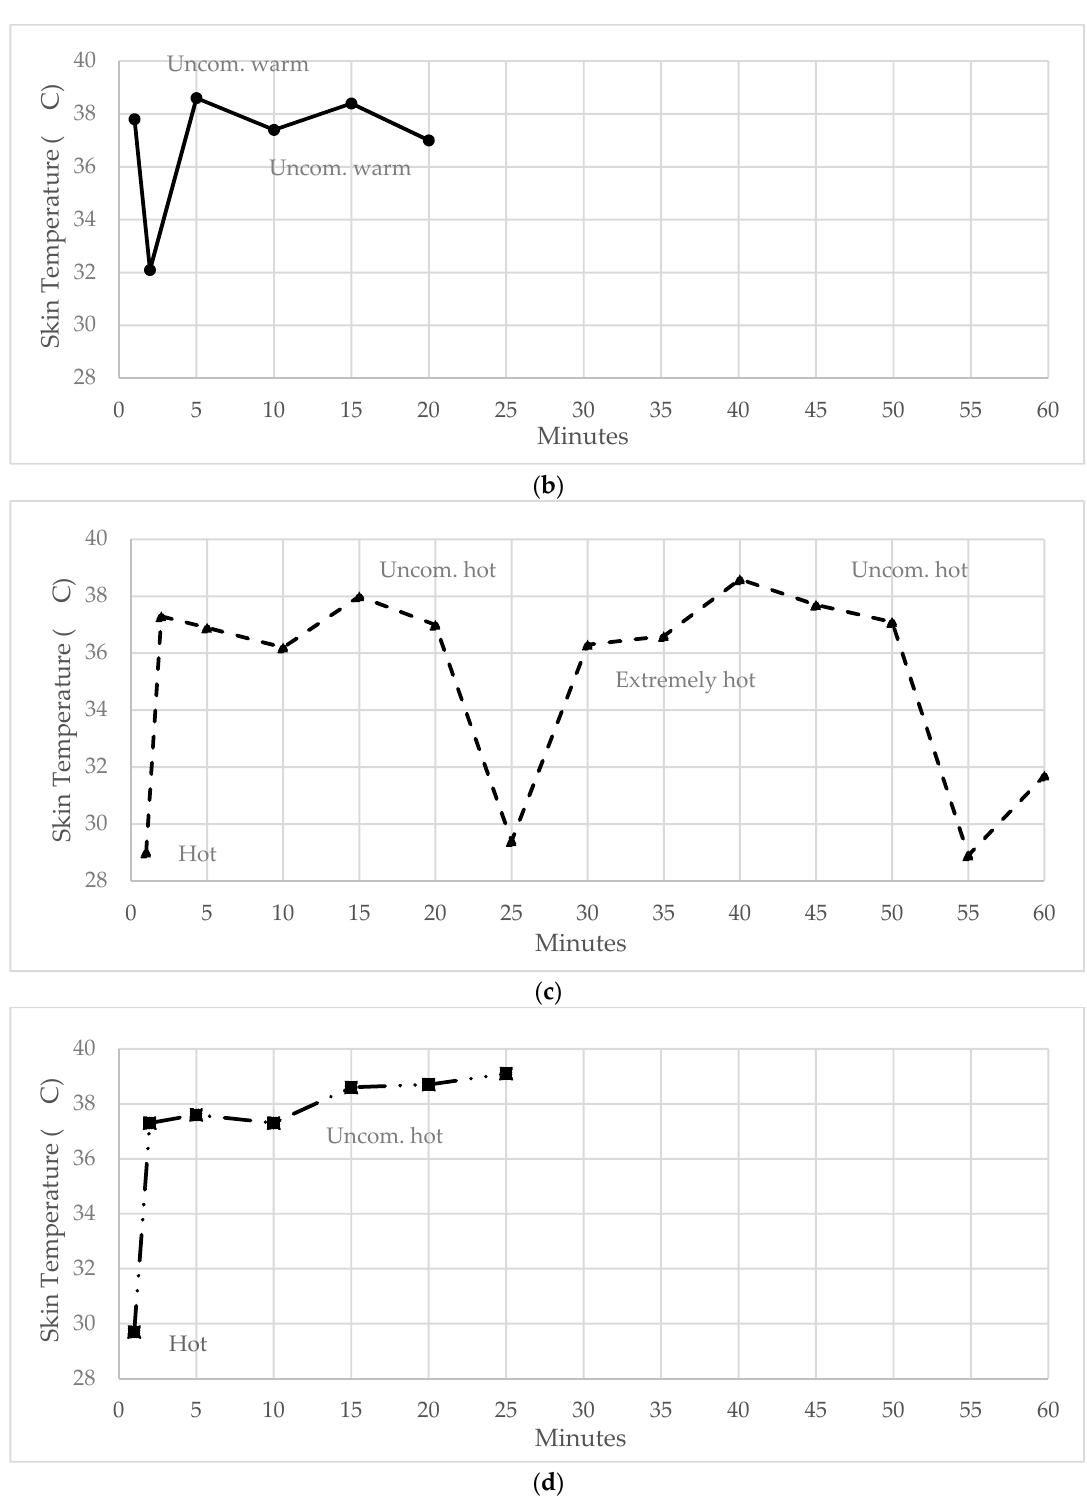
Figure 2. ( a ) Facial heat pattern. Illustrations show average facial skin temperatures collected during warm, hot, and extremely hot days. ( b ) warm (July 25), ( c ) hot (August 1), and ( d ) extremely hot (July 23) conditions and verbal comfort feedback.